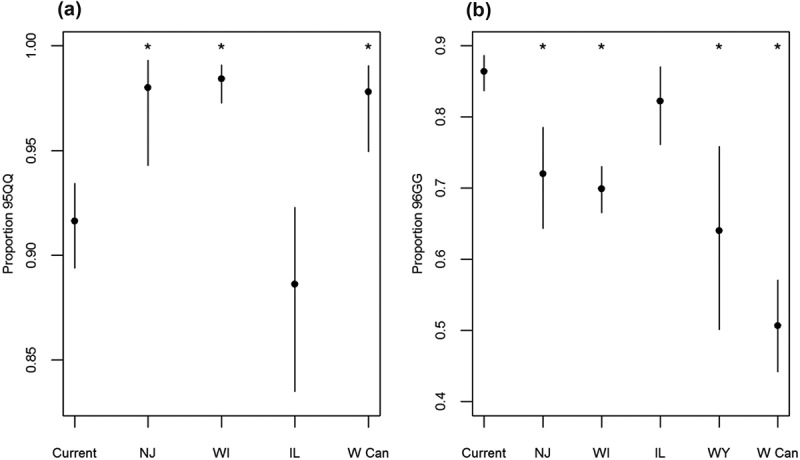
Comparison of the genotype frequencies for (a) codon 95 and (b) codon 96 among North American white-tailed deer populations (Current = Current study region; NJ = New Jersey; WI = Wisconsin; IL = Illinois; WY = Wyoming; W Can = western Canada). Asterisks indicate genotype frequencies that are significantly different from those in the study region, as determined by Fisher’s exact tests. Bars indicate 95% confidence intervals for genotype frequencies.